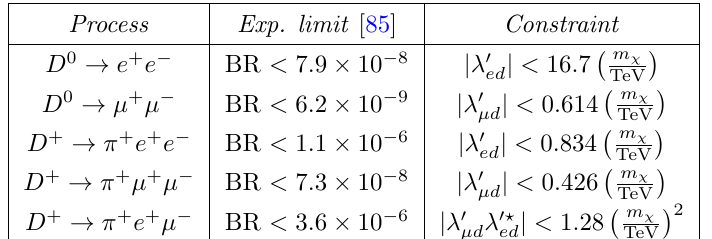
Table 15 . Constraints on the (cid:31) LQ Yukawa couplings from D 0 with q 2 = ( p p ) 2 . Since the F 1 2 (cid:0)